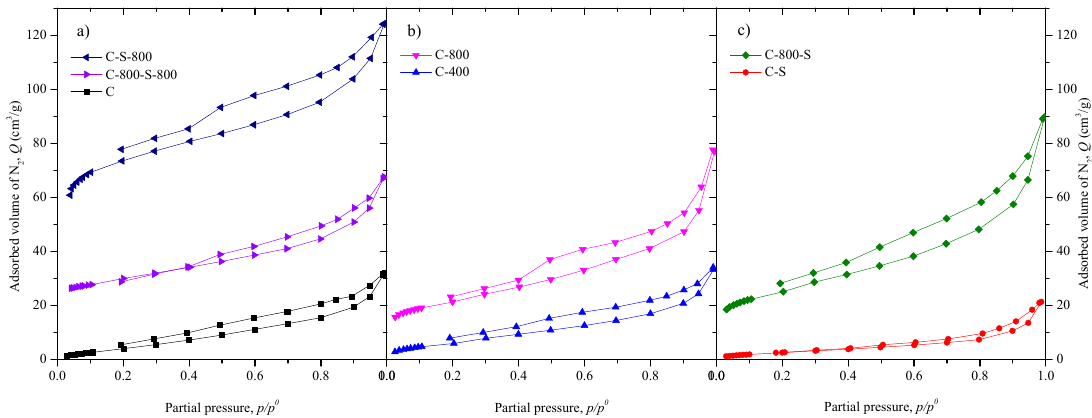
Figure 3. N 2 adsorption-desorption isotherms at 77 K of the activated ( a ), thermal-treated ( b ) and functionalized materials ( c ).